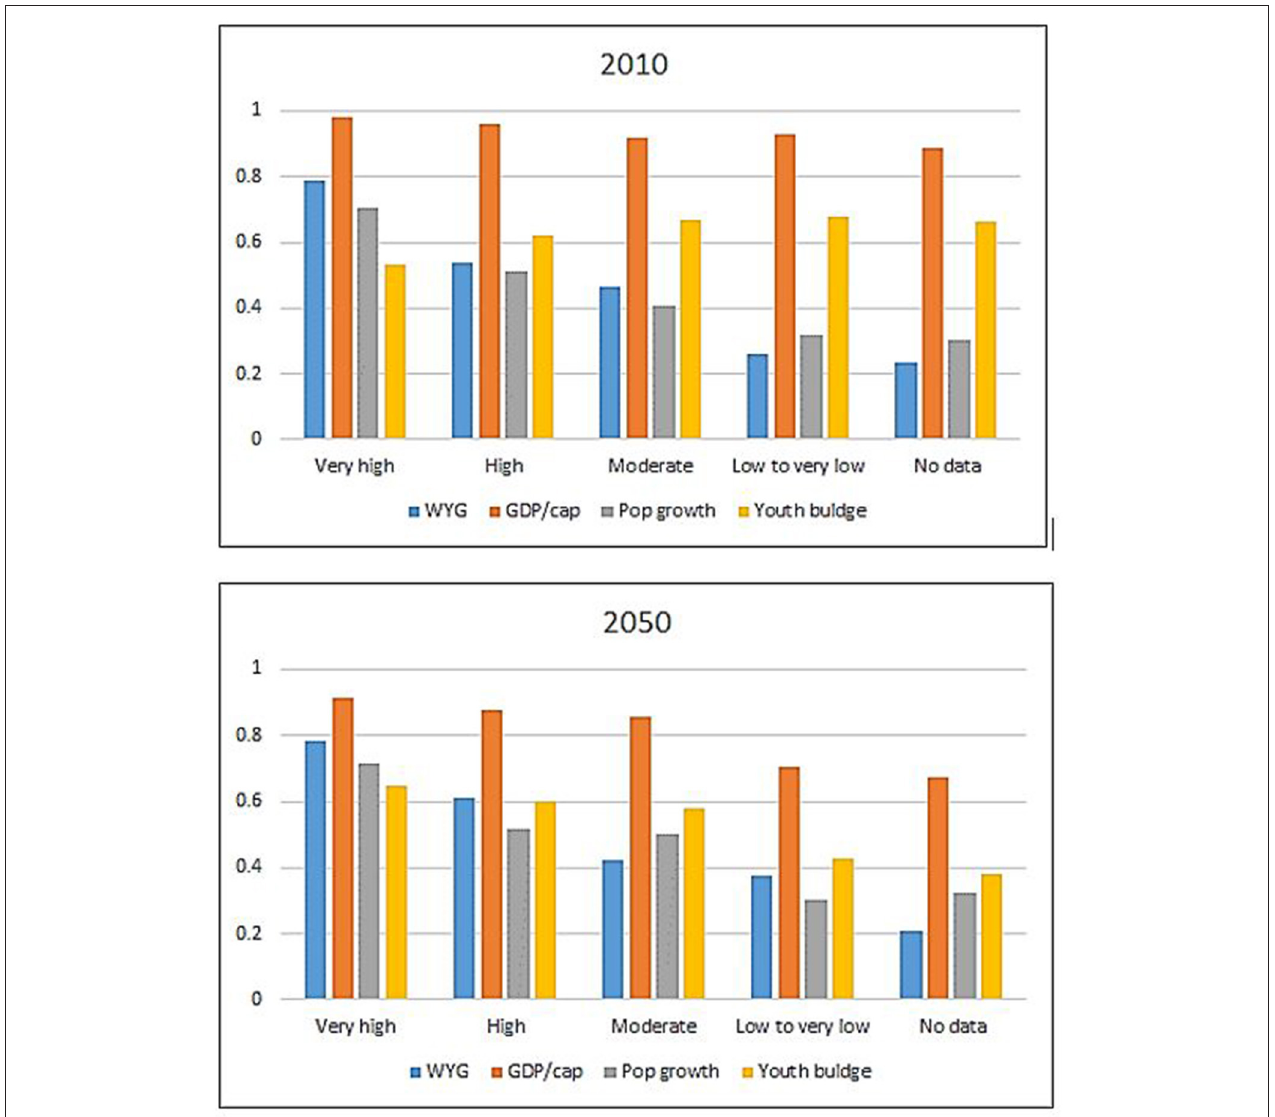
FIGURE 6 | Average value of the four normalized indicators of the migration model for every legend class for 2010 and 2050. Gross domestic product per capita is depicted inversely: 1 being very low and 0 being very high, the other indicators are depicted in the same direction as their value: 1 meaning either a very high water yield gap, a very high share of youth, or a rapid increase of